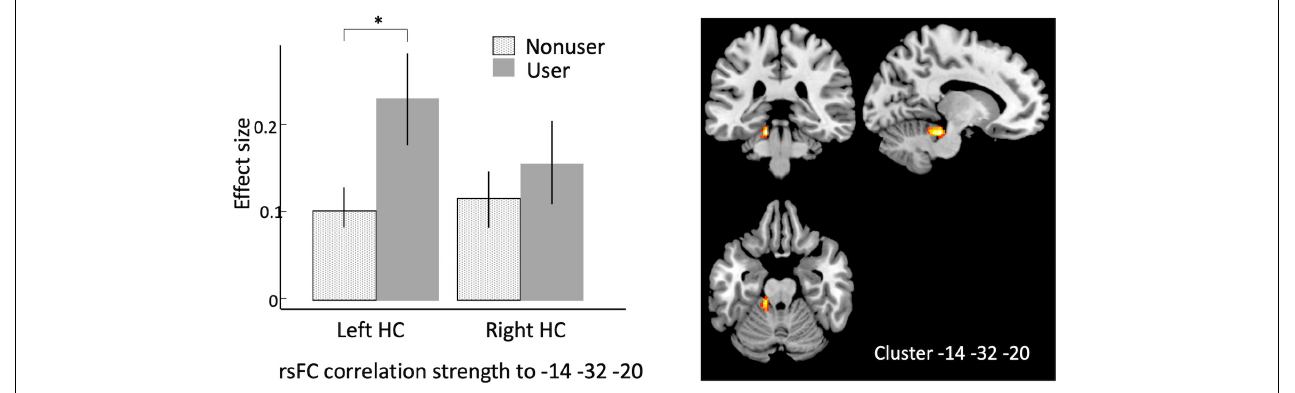
FIGURE 1 | Seed-to-voxel analysis using bilateral hippocampi as seeds, contrasting older cannabis users vs. older cannabis non-users. Hippocampal seeds show stronger correlation to a cluster in left cerebellum at in older cannabis users vs. older non-users. Left, effect sizes of left vs. right hippocampus connectivity to the peak voxel in older non-users (stippled bar) and older users (solid bar); Right, warm colors represent significant voxels of heightened connectivity from hippocampus, overlaid on canonical anatomical scan (peak voxel at x = –14, y = –32, z = –20) . HC, hippocampus. Asterisk indicates p < 0.00001, error bars indicate 95% C.l.